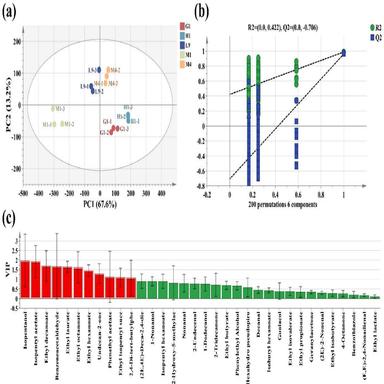
PLS-DA analysis of aroma compounds in baijiu. (a) Score plot; (b) permutation test; (c) VIP plot.